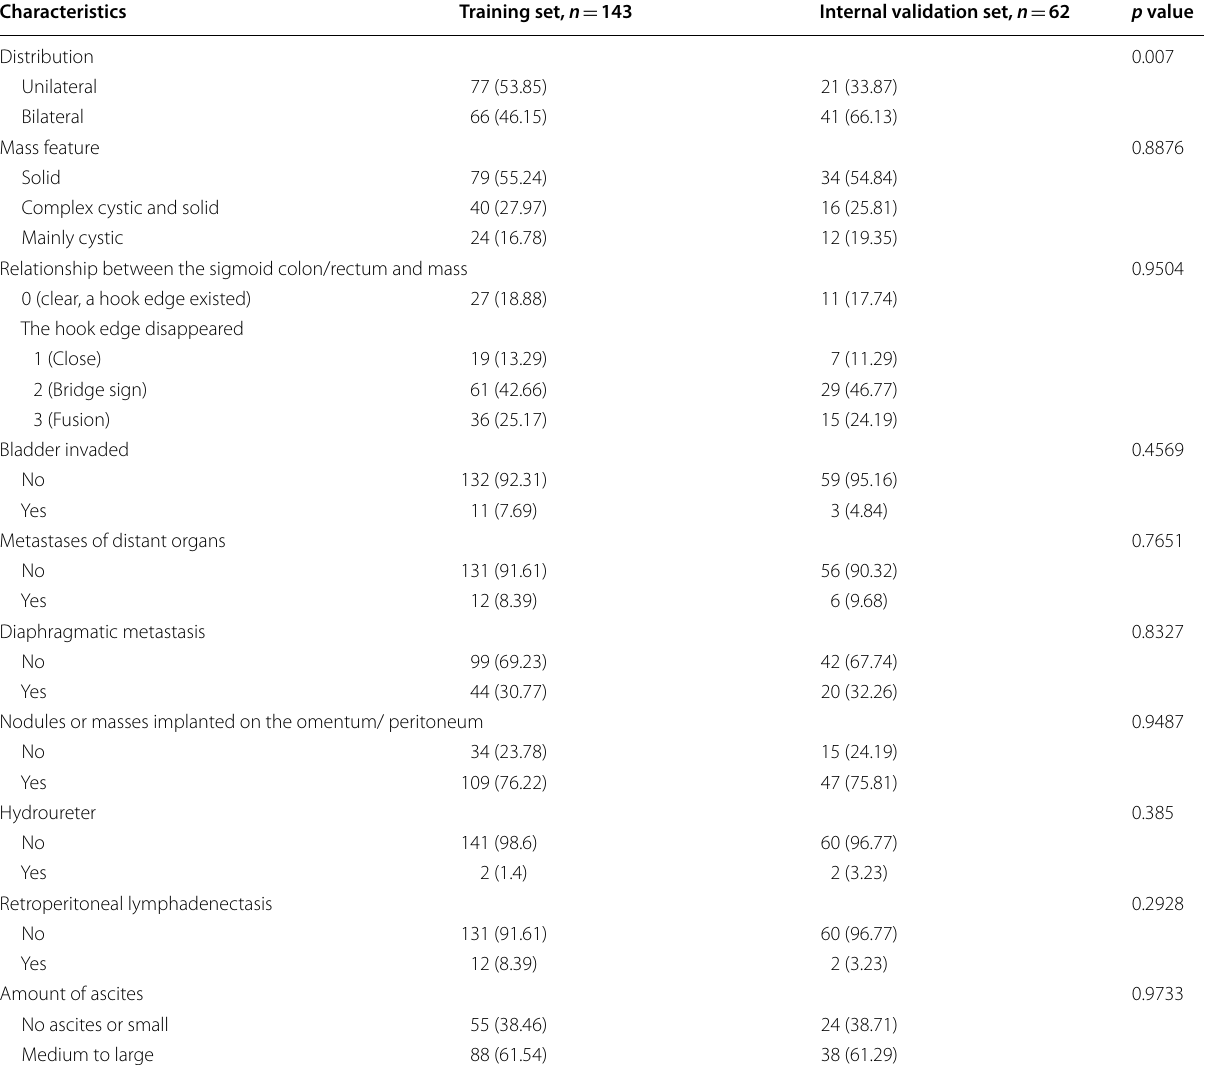
Table 2 MRI characteristics of patients with SOC from institution A